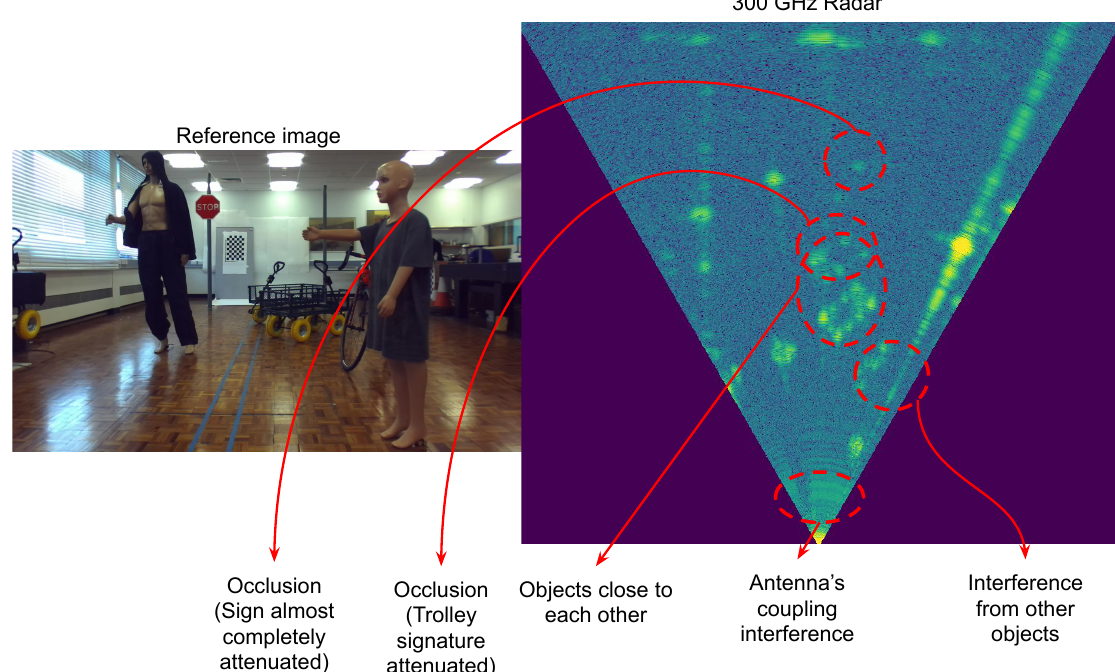
Figure 9. Possible unwanted effects in the multiple object